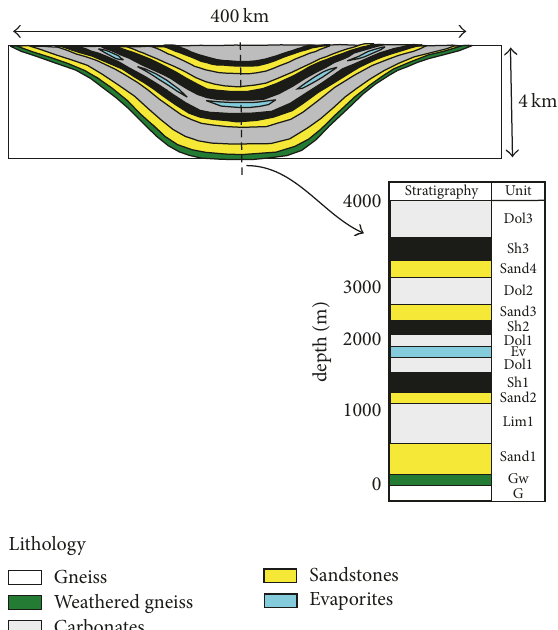
Figure 1: Domain, geology, and stratigraphy used to simulate the impact of continental glaciation on O 2 ingress and attenuation in a hypothetical sedimentary